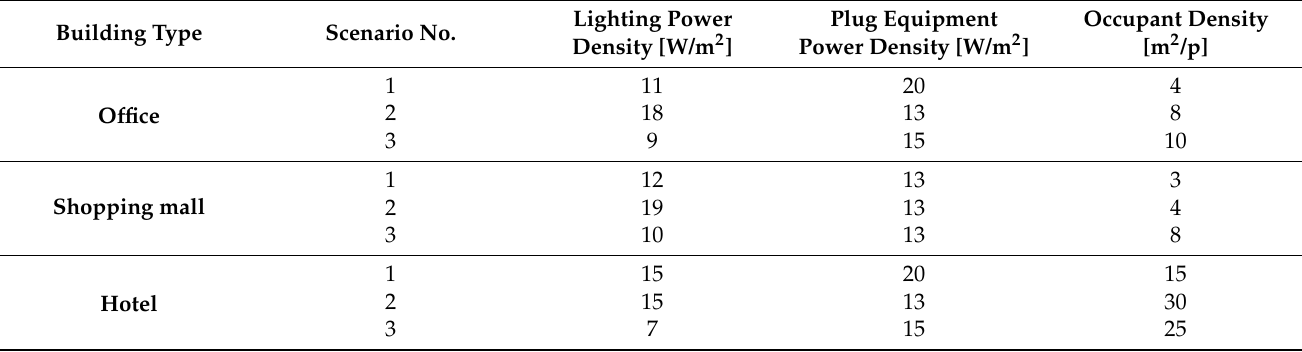
Table 4. Benchmark values of indoor condition parameters in